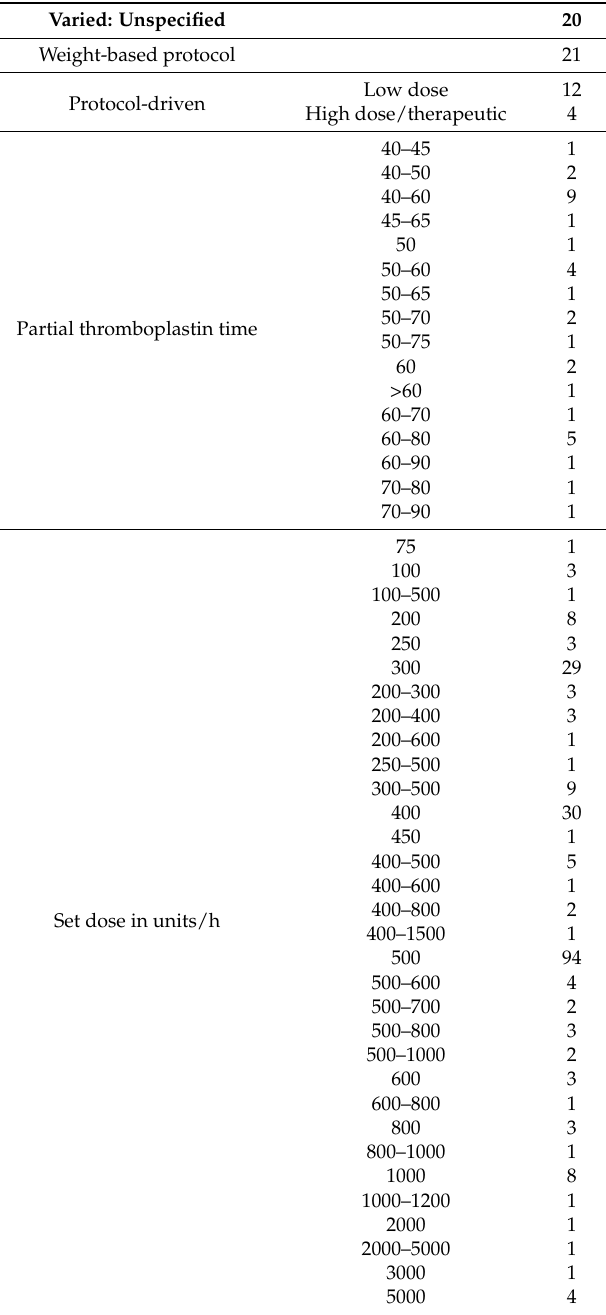
Table 2. Systemic heparin